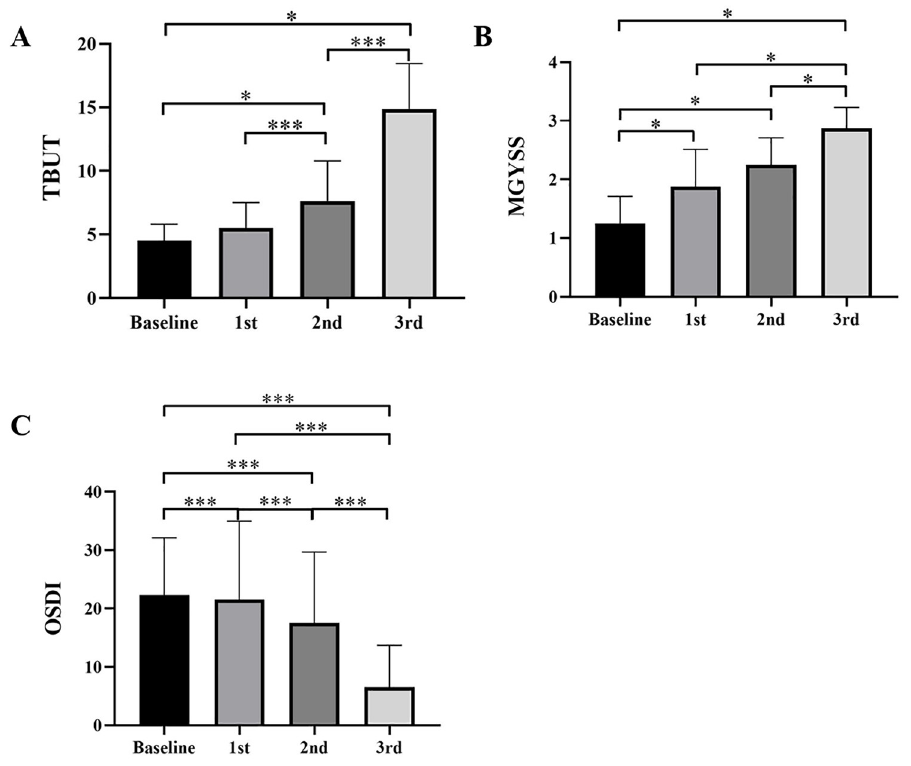
Fig 1. Change of clinical evaluators following each IPL treatment session in patients with MGD. (A) TBUT, (B) MGYSS, (C) OSDI. � P < 0.05, ��� P < 0.001.